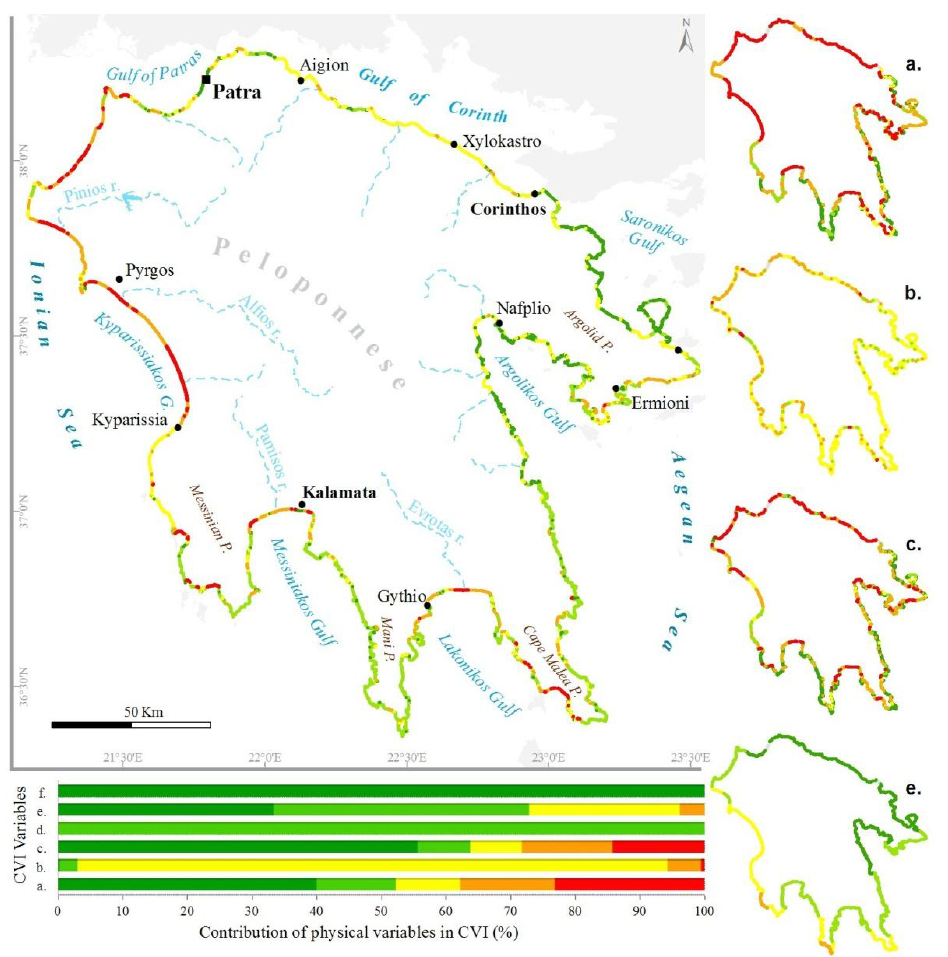
Figure 2. Maps of classification of the Peloponnese coastline into five physical vulnerability classes according to the variables of the Coastal Vulnerability Index (CVI) values. Inset maps ( a – c , e ) indicate the vulnerability ranking of various segments of the coast based on the CVI variables (( a ) geomorphology, ( b ) shoreline change rate, ( c ) coastal slope and ( e ) mean significant wave height). Since the variables of relative sea-level rise and tidal range are considered to have the same value along the entire coastline of the Peloponnese, the figure does not include vulnerability ranking maps for these variables. The bar diagram shows the length (in percentage %) of shoreline in each vulnerability category for the CVI variables.